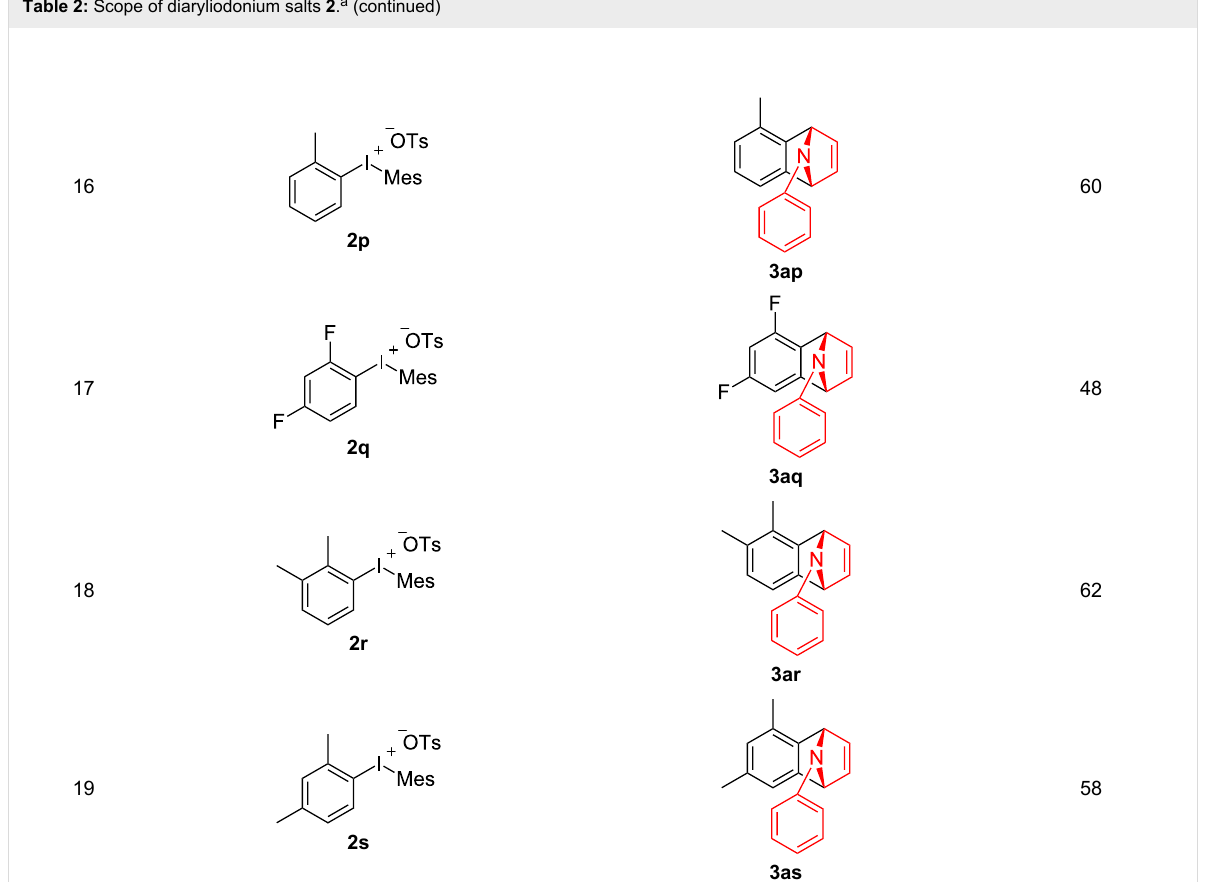
Table 2: Scope of diaryliodonium salts 2 . a (continued)